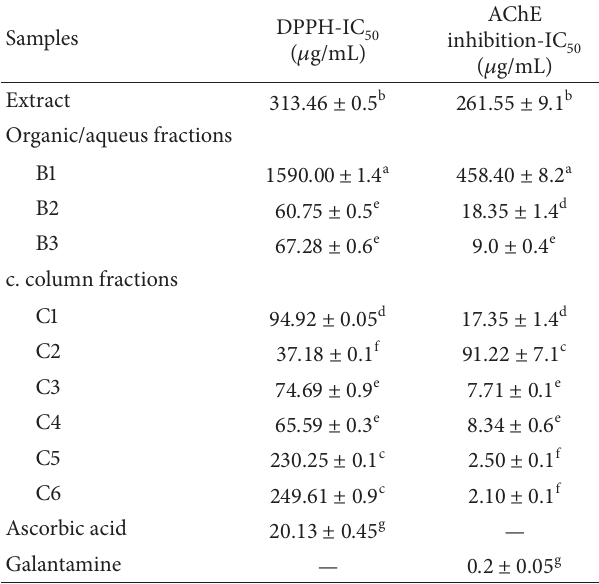
Table 2: Antioxidant and anticholinesterasic activity of T. cathari- nensis extract and fractions.